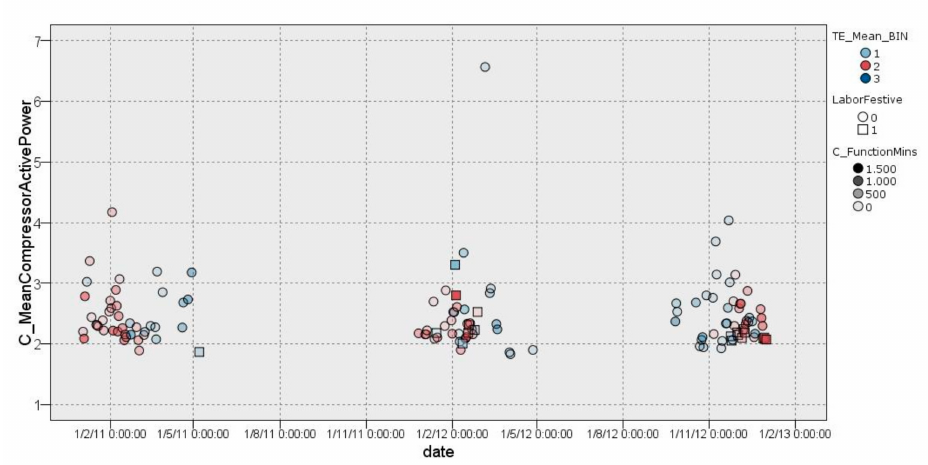
Figure 5. Graphical representation of distribution of cluster 1.